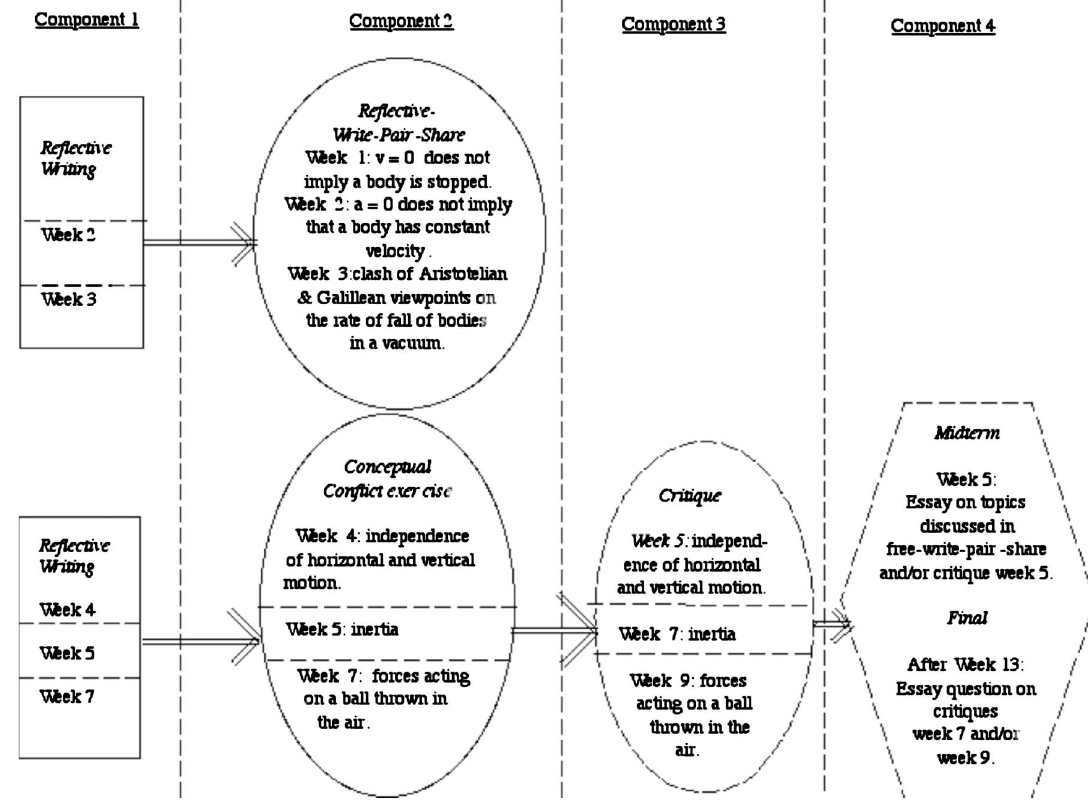
FIG. 1. The set of different activities including four components utilized in the